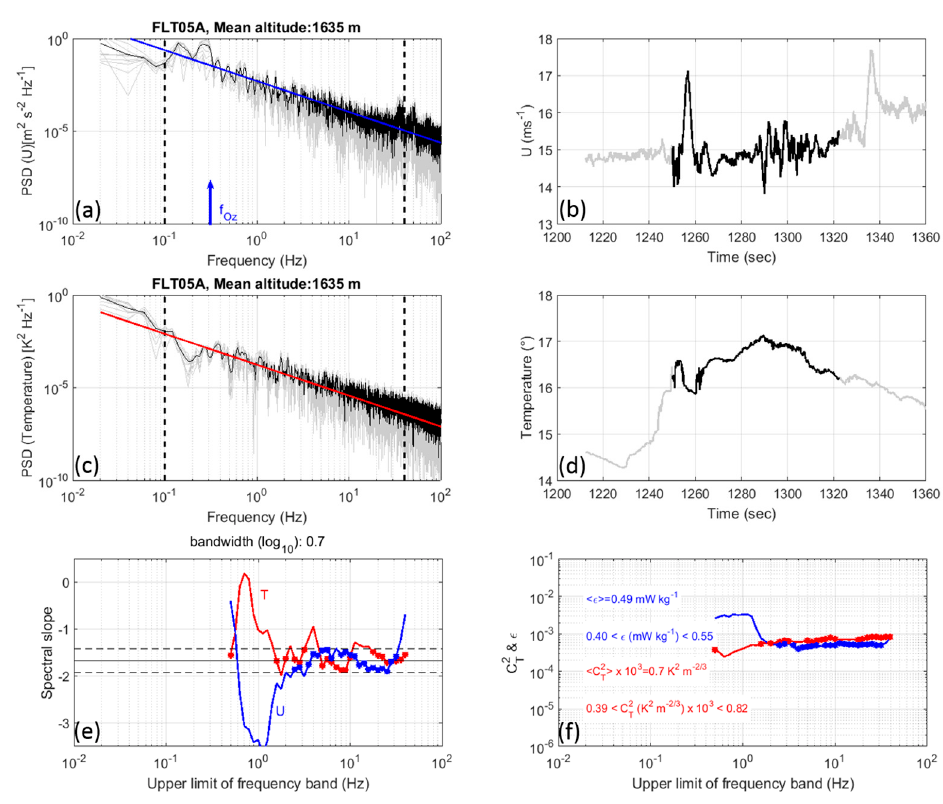
Figure 2. A “strong turbulence” case during FLT05A around 1635 m altitude. ( a ) A 1–D streamwise frequency spectra of U time series. Mean spectrum averaged over 10 consecutive (overlapping) time intervals (black). The corresponding non averaged spectra (gray). The blue line shows the − 5 / 3 slope. The vertical thick dashed lines show the 0.1 − 40 Hz frequency range used for the analysis. ( b ) The corresponding time series of U highlighted in black. ( c ) Same as ( a ) for T. ( d ) Same as ( b ) for T. ( e ) Slopes of U (blue) and T (red) spectra vs. f max . The horizontal solid and dashed lines show − 5 / 3 and − 5 / 3 ± 0.25 slopes, respectively. ( f ) The corresponding estimates of ε (blue) and C 2 (red) vs. f max . The corresponding U spectral bands show a tendency close to − 5/3 up to f max ≈ 30 Hz . The